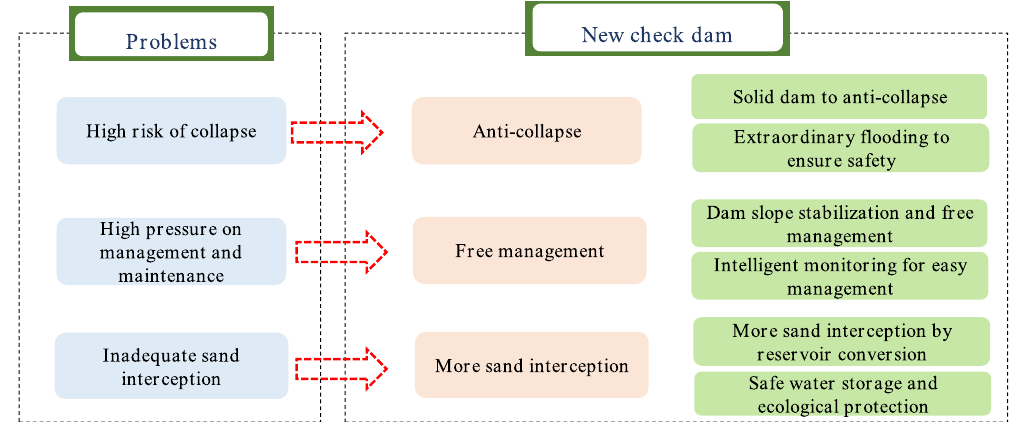
Figure 4. The concept of a new check dam.